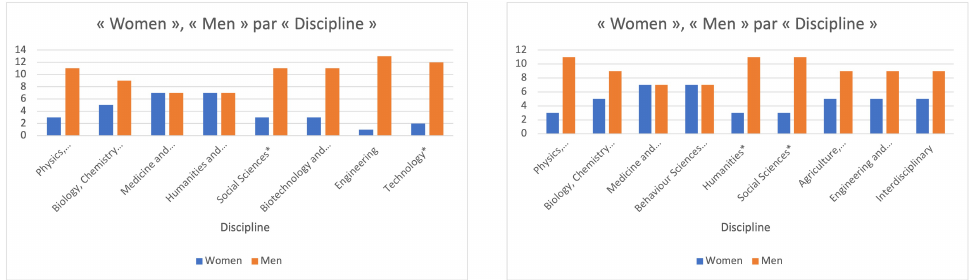
Figure 2. Comparison between the composition of commission members by gender and discipline between 2016 and 2020. Commissions with a * have female presidents. The complete names of the items with “...” are given in the text.